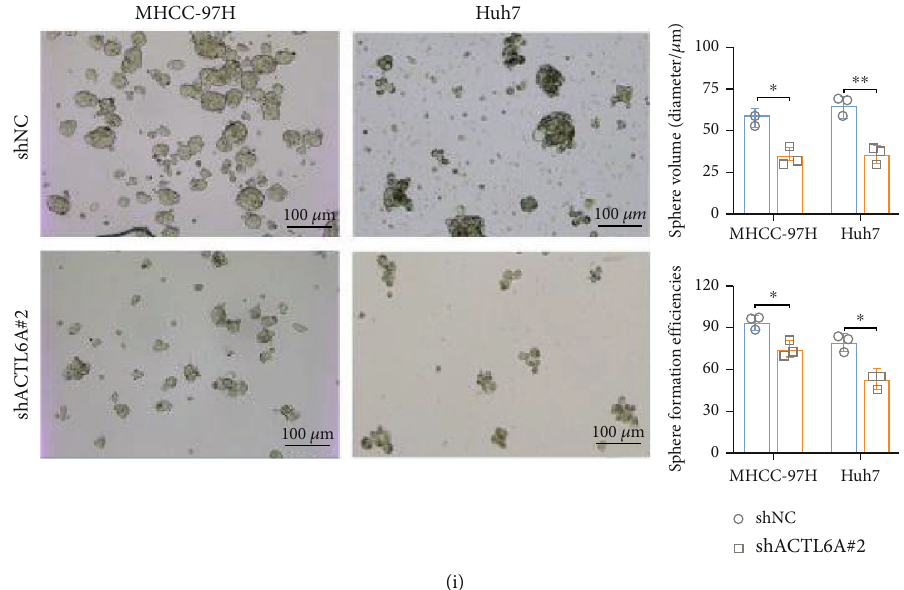
Figure 4: E3 ubiquitin ligase FBXW7 interacts with ACTL6A. (a) Cell extracts from MHCC-97 cells with Flag-FBXW7 expression were immunopuri fi ed on an anti-Flag a ffi nity column and eluted with Flag peptides. The eluates were analyzed by mass spectrometry. (b) Predictive analysis of E3 ubiquitin ligases that might target ACTL6A was performed using UbiBrowser database. (c) Co-IP and immunoblotting detected the interaction between FBXW7 and ACTL6A. (d) IF staining of FBXW7 and ACTL6A in the above cells. (e) Western blot was used to detect the e ff ect of FBXW7 on the ACTL6A protein level. (f, g) Comparison of the expression of pluripotency- associated markers in HCC cells of di ff erent groups by Western blot. (h, i) Self-renewal abilities were measured by sphere formation assays in MHCC-97H and Huh7 cells transfected with LV-ACTL6A or shACTL6A#2. Graph represents mean ± SD ; ∗ P < 0 : 05 , ∗∗ P < 0 : 01